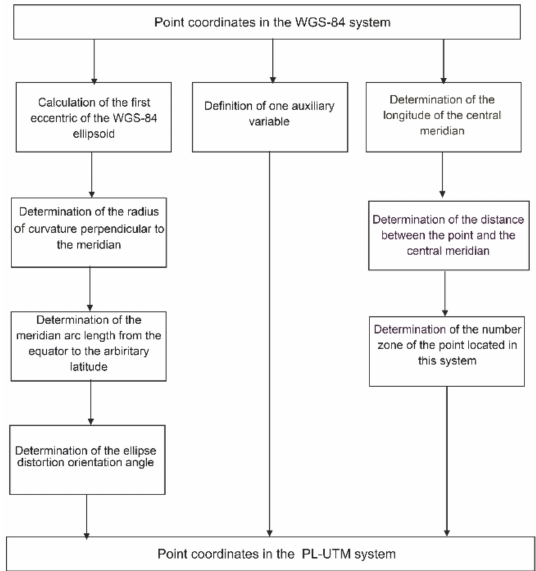
Figure 2. Flowchart showing steps of model for the transformation ellipsoidal coordinates to plane coordinates in the PL–UTM